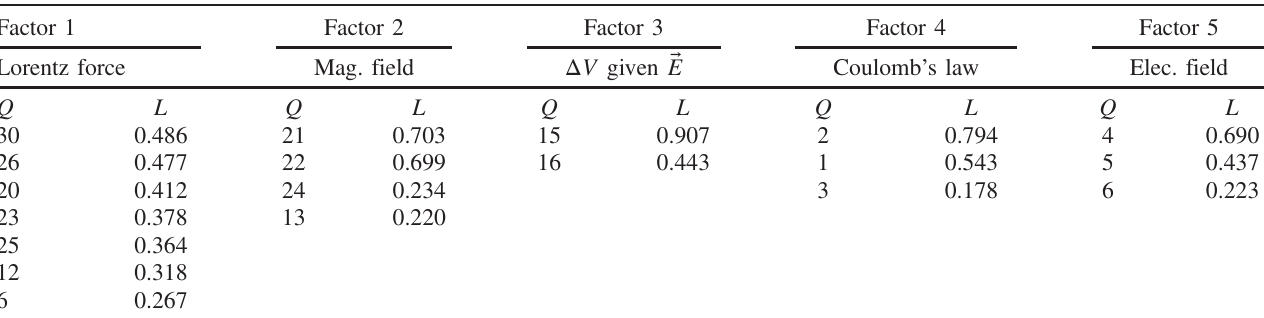
TABLE III. BEMA 5 factor EFA model. Items 9 and 18 were dropped due to poor KMO values, and the following items were dropped due to their communality values falling below the 0.1 cutoff value: 7, 8, 10, 11, 14, 17, 19, 27, 28 = 29 , and 30. All loadings above 0.15 were used for this model. Here “ Q ” indicates the questions number and “ L ” the associated loading value.